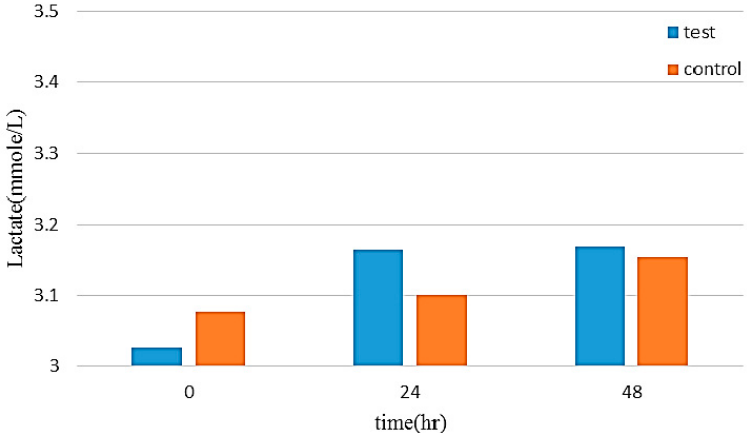
Figure 10. Experimental comparison group lactic acid content.